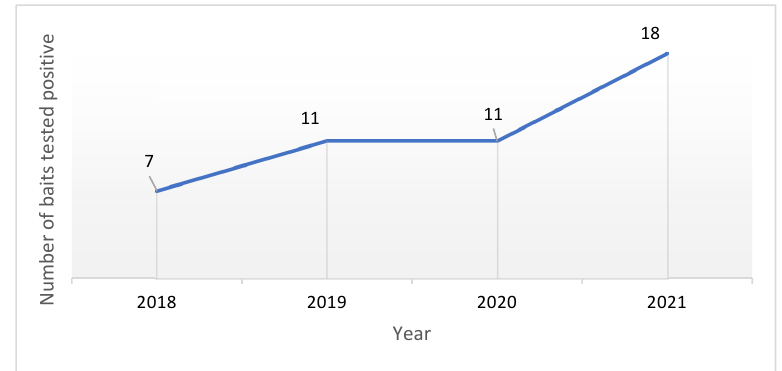
Figure 2. Number of baits tested positive, broken down by year.